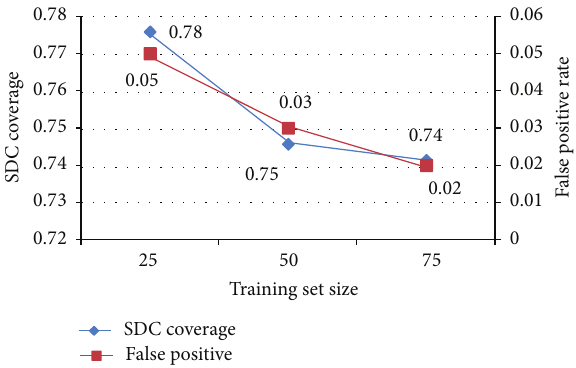
Figure 7: The SDC coverage and false positive rate for varied training set